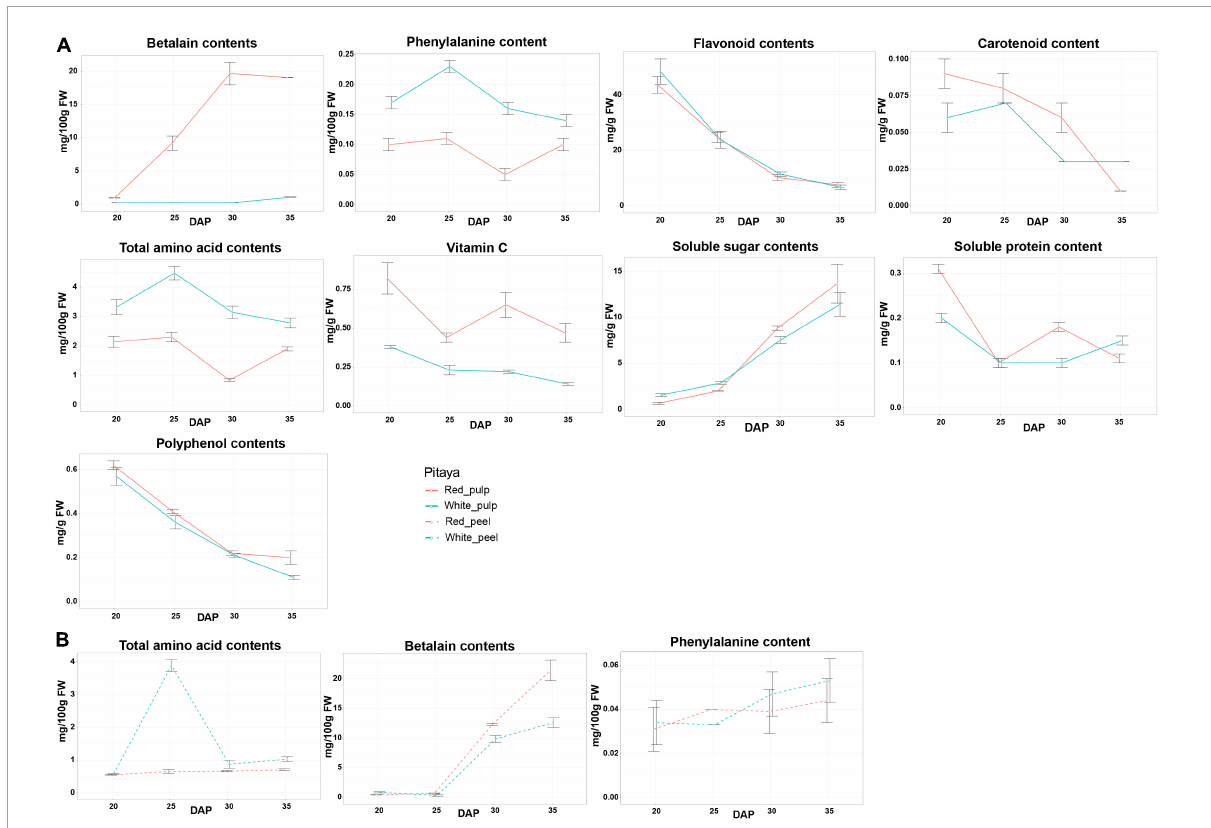
TABLE 1 Features of unigene assemblies in two commercial Hylocereus varieties.